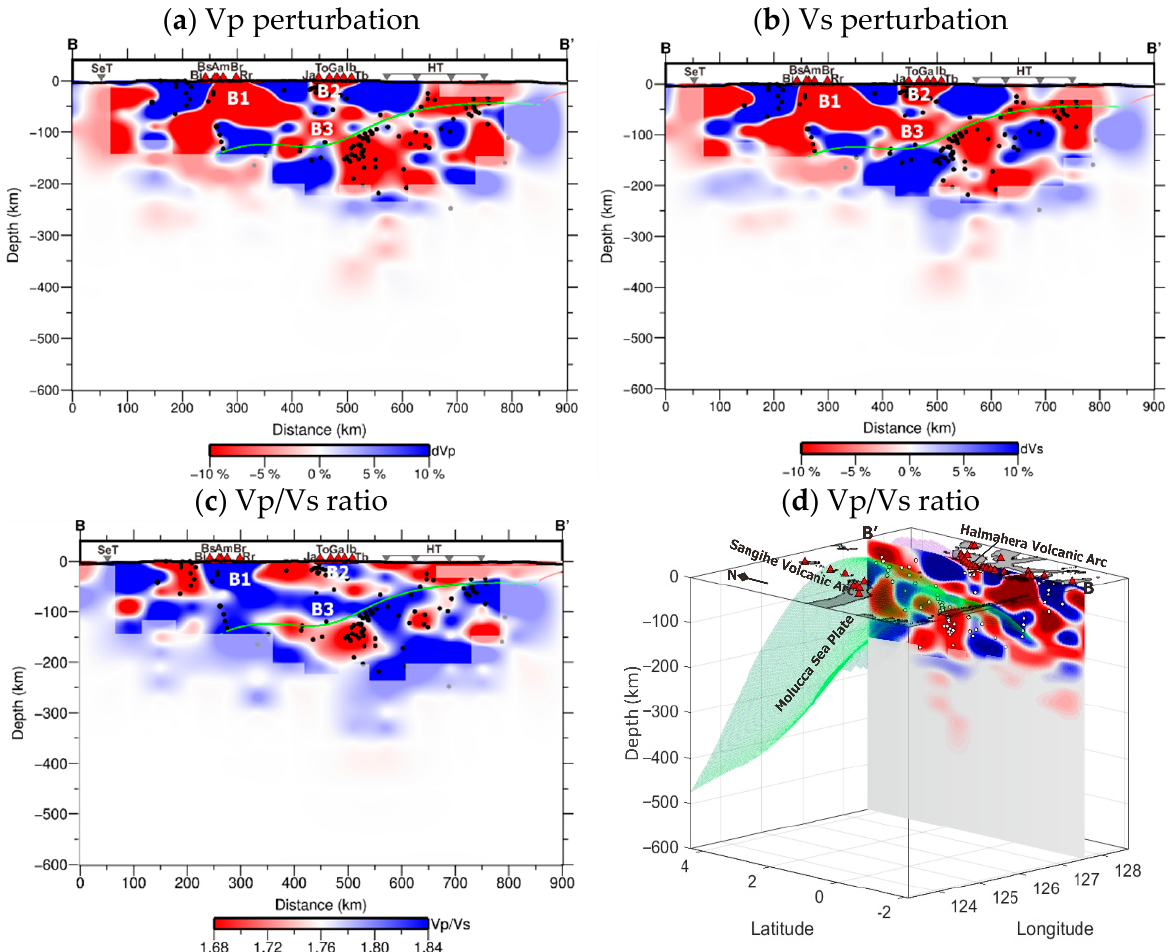
Figure 7. Vertical cross-section of B-B’ (south–north) crossing beneath the Halmahera Volcanic Arc. The red color indicates low velocity and low Vp/Vs ratio. The blue color indicates high velocity and high Vp/Vs ratio. The B1, B2, and B3 are areas for the interpretation of tomographic inversion results. The green line and the green three-dimensional surface plot are the slab2 models of the Molucca Sea Plate [45]. The black dots signify earthquakes within a radius of 30 km < B-B ′ < 30 km. SeT: Seram Trench; HT: Halmahera Trench; Bi: Bibinoi Volcano; Bs: Batusibela Volcano; Am: Amasing Volcano; Br: Buku-Rica Volcano; Rr: Rogi-Rogi Volcano; Ja: Jailolo Volcano; To: Todoko-Ranu Volcano; Ga: Gamkonora Volcano; Ib: Ibu Volcano; Tb: Tobaru Volcano. The blurred area is an area that is not well-resolved.